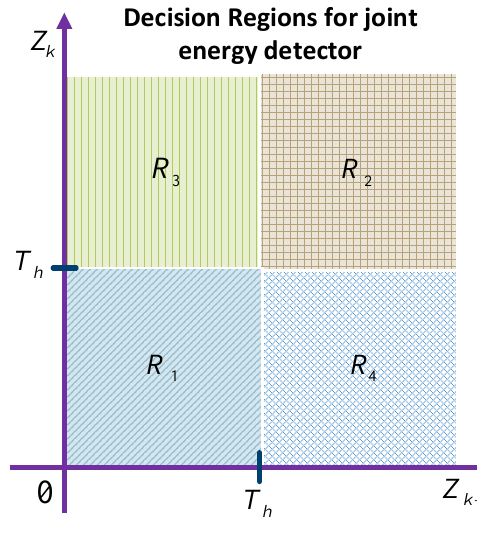
Figure 17. Non-Coherent Detection for